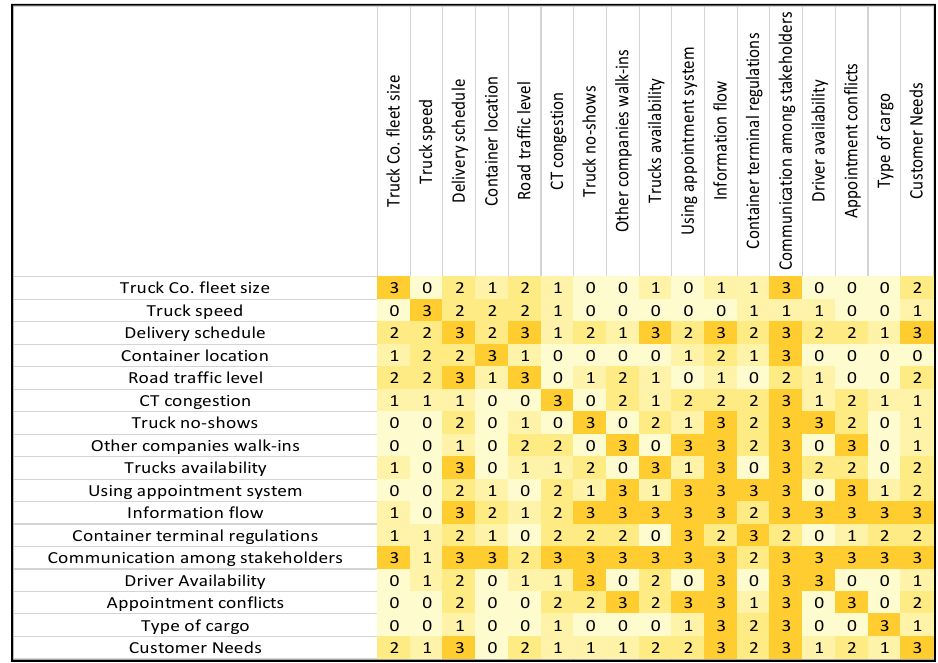
Figure 3. Insight matrix before sorting based on the strength of the correlation between the factors.